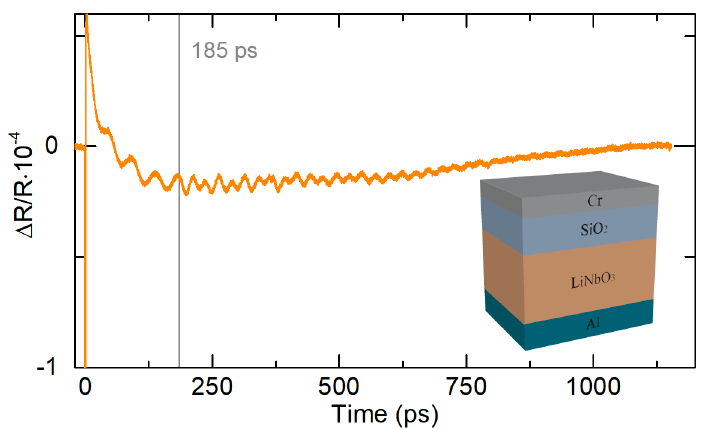
Figure 1. Transient reflectivity changes of the sample. Inset: Sample structure; from top to bottom, the sample consists of a layer of 18-nm Cr, 1140-nm SiO 2 , 325- µ m LiNbO 3 , and 100-nm Al (thicknesses are not to scale).